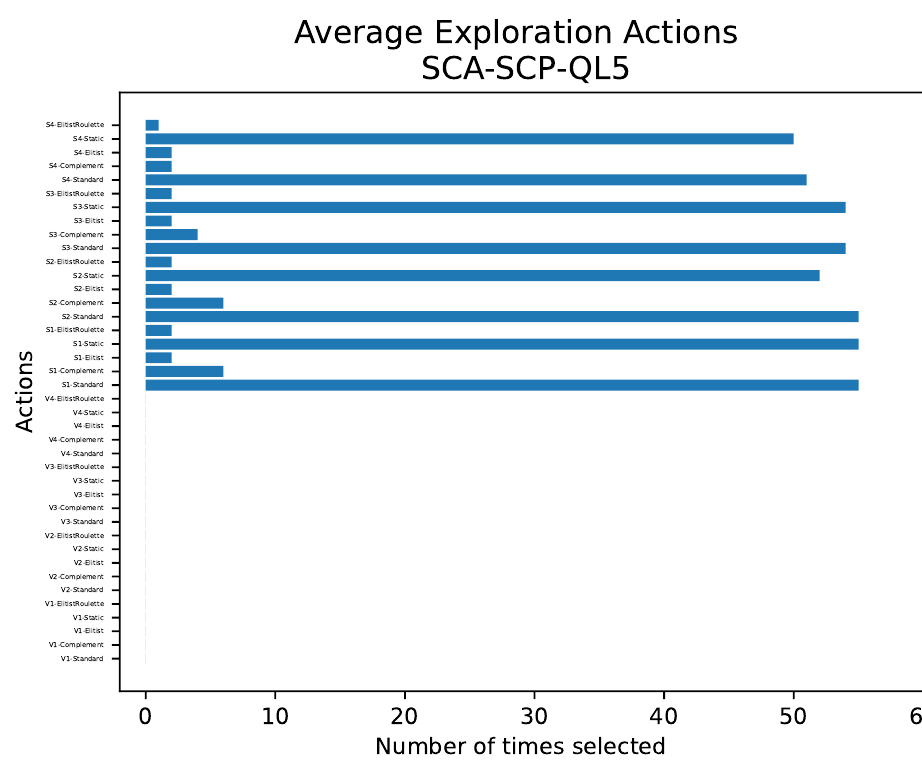
Figure 9. SCA-QL5—The average number of actions in the exploration